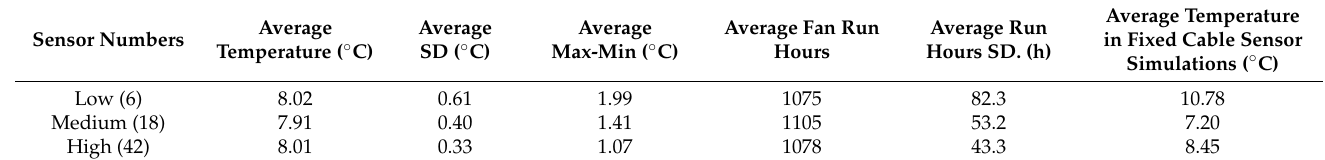
Table 3. Results of ten simulations each of randomized horizontal placement of wireless sensors at fixed grain depths for numbers of sensors corresponding to each of the three cable configurations defined in Figure 2. Average temperature, average standard deviation (SD.), the average difference between the maximum and minimum values, average fan run hours, and average standard deviation of fan-run hours are the respective averages across each set of ten simulations. The last volume lists the corresponding average temperature for each configuration predicted by the temperature cables. The results reflect a one-year controlled aeration simulation of 1346 MT of maize beginning 1 October, 2014. The fan was turned on whenever ambient air was cooler than the average of the sensors and the average was above 0 ◦ C.